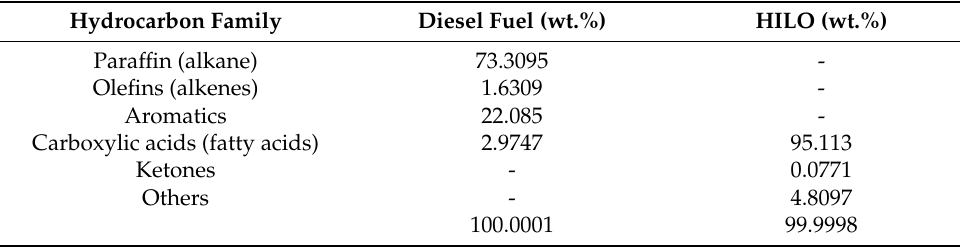
Table 3. Summary of the chemical compound in diesel fuel and